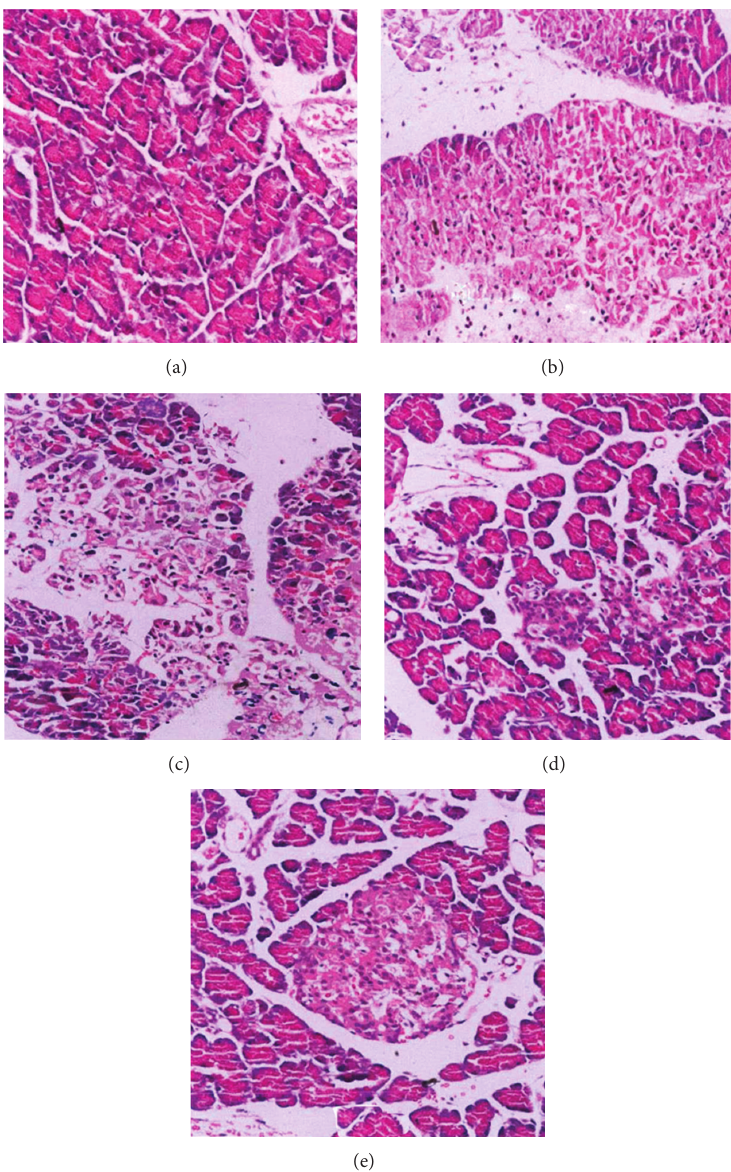
Figure 1: The HE staining of pancreas (HE 400x) in five groups. (a) Group 1, normal control group; (b) group 2, T2DM (type II diabetes mellitus) control group; (c) group 3, 25 𝜇 g/kg CrPic group; (d) group 4, 50 𝜇 g/kg CrPic group; and (e) group 5, 100 𝜇 g/kg CrPic group.